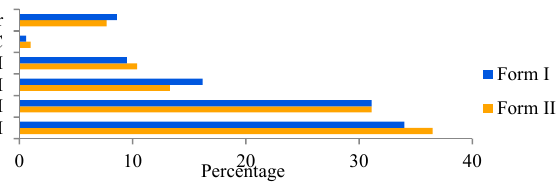
Figure 8. Bar-chart representing the percentage contribution of the main contacts in the Hirshfeld surfaces of forms I and II. The category of “other” includes C ‧‧‧ N and C ‧‧‧ O interactions. The spikes at the bottom left of both plots are very prominent, exhibiting the domi- nance of N ‧‧‧ H and O ‧‧‧ H contacts, due to the highly polar functional groups in ganciclovir. The presence of these contacts is in agreement with the full interaction maps and the hy- drogen bonds predicted by Mercury. The greener shades on the spikes of the form I surface plot indicate a higher frequency of contacts having relatively shorter distances. The per- centage contribution of O ‧‧‧ H interactions is equivalent for both forms, but the global min- imum distance d i + d e of around 1.7 Å pertains to form I.